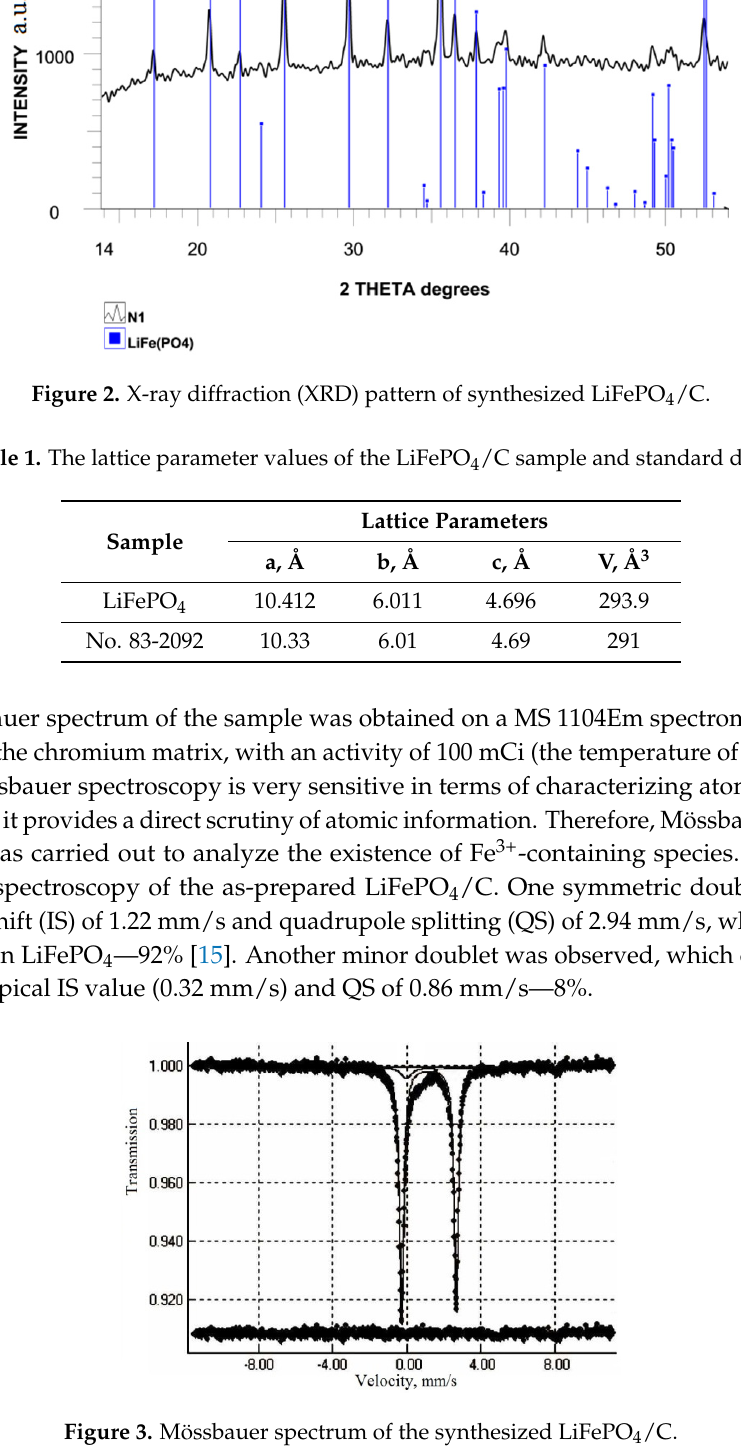
Figure 3. Mössbauer spectrum of the synthesized LiFePO 4 /C.